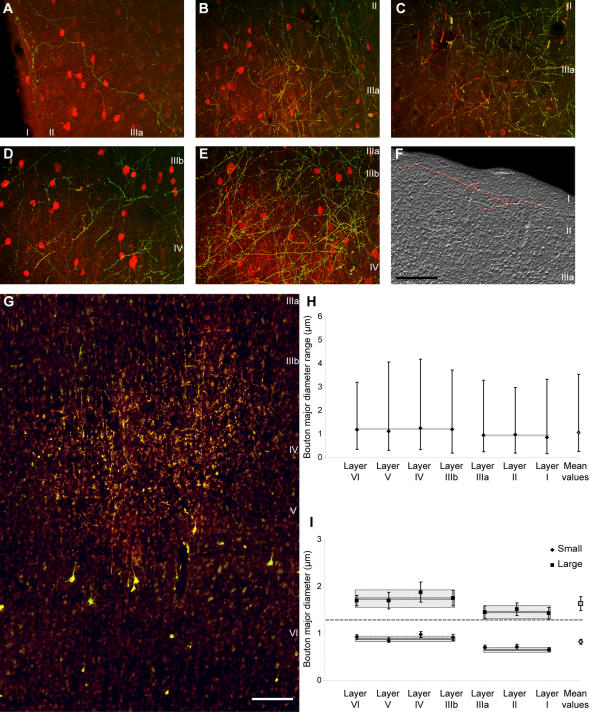
Thalamo-cortical terminations in different layers of the prefrontal cortex.Most thalamo-cortical terminals in the superficial layers are CB+, whereas in the middle-deep layers most are PV+. A–C, Thalamo-cortical terminals (green) in prefrontal cortex from the ventral anterior nucleus and their relationship to CB+ processes and local inhibitory neurons (red). Yellow shows double labeled thalamo-cortical terminals that are CB+. Axonal terminations from the ventral anterior nucleus in the superficial layers of: A, area 32; B, area 9; C, area 46. D–E, Thalamo-cortical terminals (green) in the prefrontal cortex from the ventral anterior nucleus and their relationship to PV+ processes and local PV+ inhibitory neurons (red). Yellow shows double labeled thalamo-cortical terminals that are PV+. Axonal terminations from the ventral anterior nucleus in the middle-deep layers of: D, area 46; E, area 9. F, Widespread axonal terminations of small and large boutons in the superficial layers of area 9. One thalamo-cortical axon is shown in pseudo-color (red). G, Focused axonal terminations in the middle-deep layers of area 9. Labeled cortico-thalamic neurons are seen in layers V and VI. H, Mean major diameter of boutons from axons originating in the ventral anterior nucleus and terminating in different layers of the prefrontal cortex. The range of diameters of boutons (vertical solid lines) and the mean values in the superficial and middle-deep layers (grey boxes) are also indicated. I, Cluster analysis of the diameter of boutons (± variance) emanating from the ventral anterior nucleus and terminating in different prefrontal cortical layers. Populations of small and large boutons can be identified in all layers; however, boutons in the superficial layers are significantly smaller than in the middle-deep layers. Dark and light grey boxes indicate the mean values±standard error in the superficial and middle-deep layers. Scale bars: A–F, 100 µm; G, 200 µm.